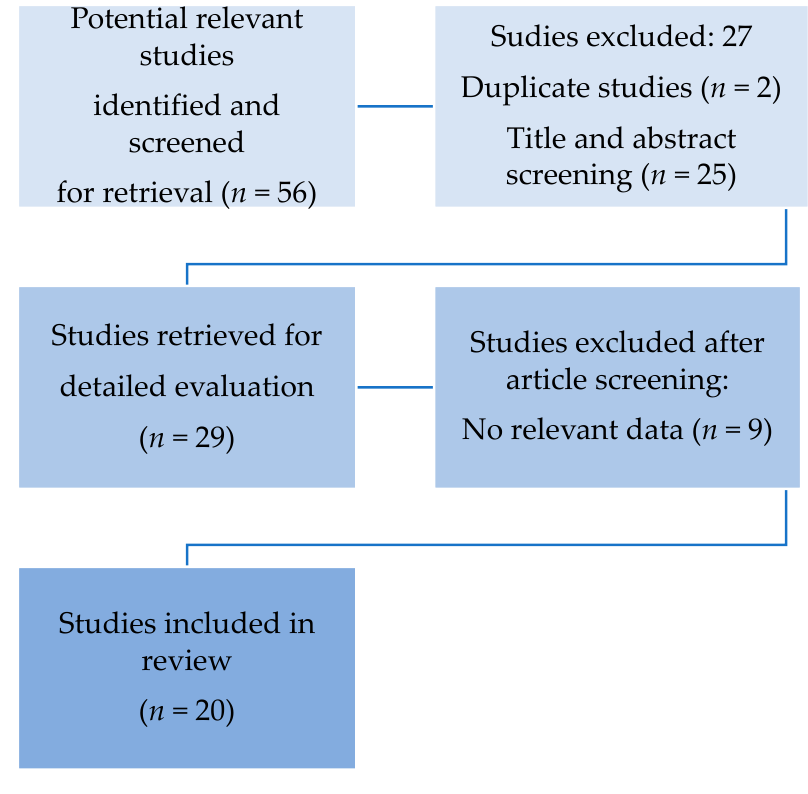
Figure 1. Search strategy.